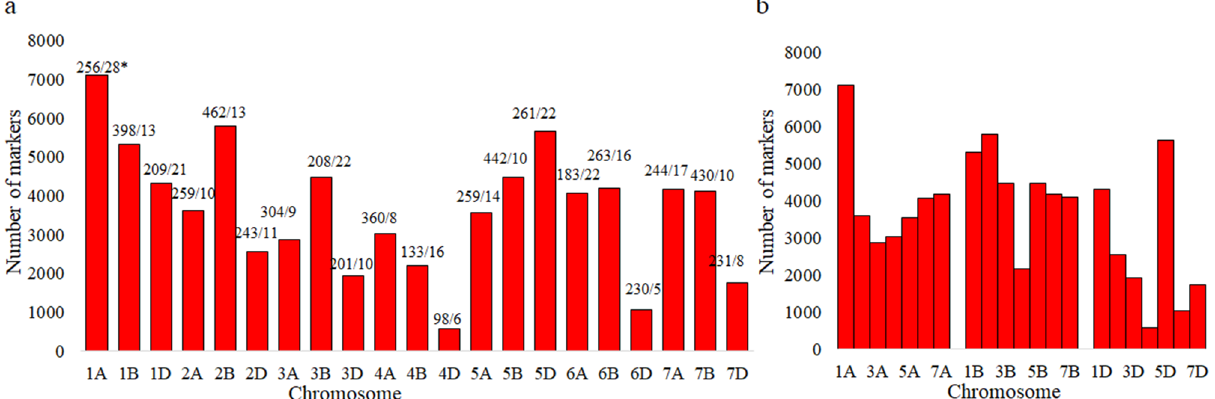
Figure 2. Summary of the number of markers on each of the 21 wheat chromosome ( a ) grouped according to homoeologous chromosomes, and ( b ) grouped according to the three sub-genomes. * = Chr. Length/marker